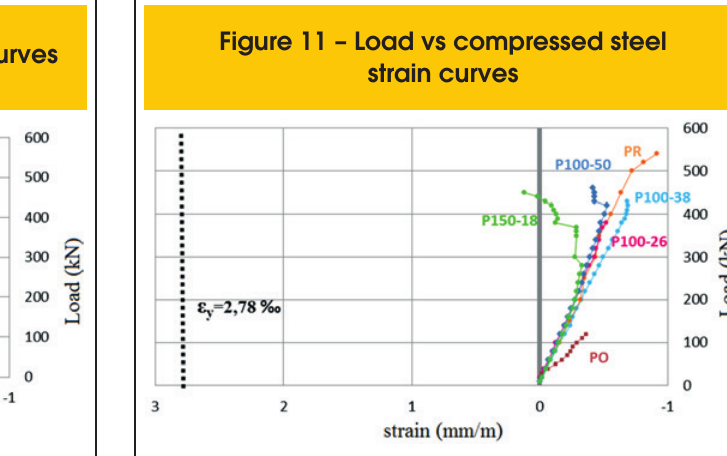
Figure 10 – Load vs tension steel strain curves